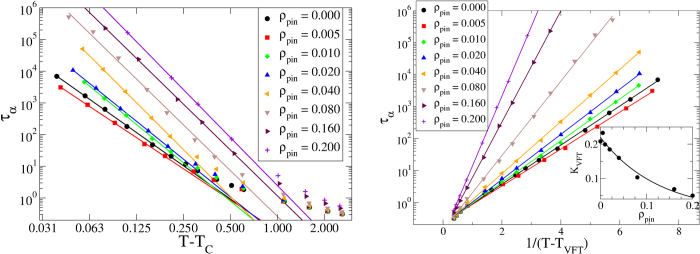
MCT and VFT Fits for 3dKA Model.Left Panel: Power-law fits to obtain TC as a function of ρpin for the 3dKA model. Right Panel: VFT fits to obtain TVFT as a function of ρpin for the 3dKA model. Inset: Kinetic fragility KVFT as a function of ρpin. The dramatic decrease in TVFT with increasing ρpin can be clearly seen. The line is an exponential fit to the data.